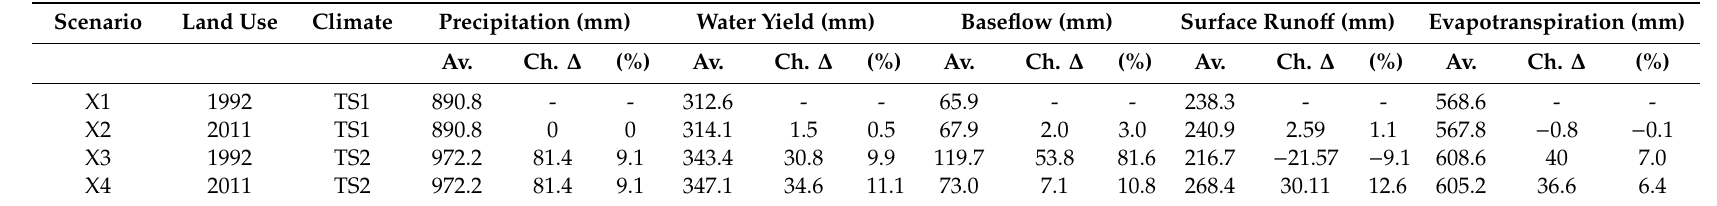
Table 9. Average annual change in water balance components in the UWBDR watershed.